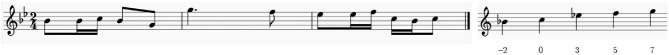
A list of suitable octave-invariant responses for the selected excerpt from the Chinese dataset in the pentatonic scale starting in B♭.